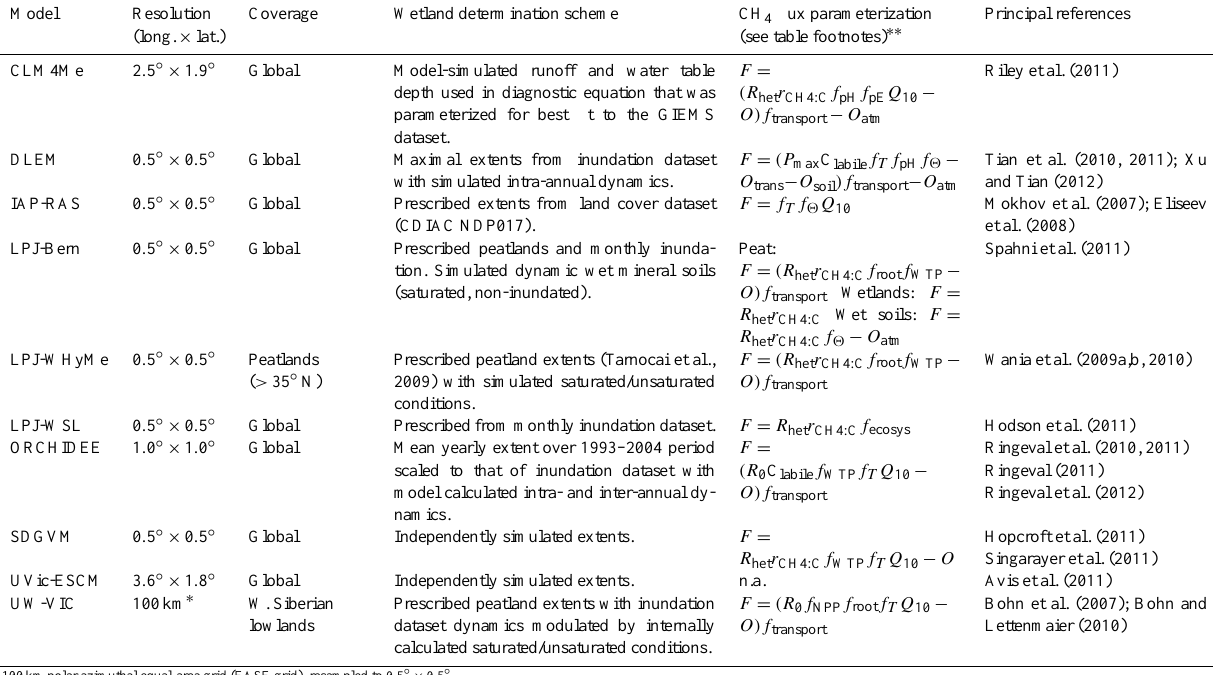
Table 1. List of WETCHIMP participating models. Not all models contributed results to all experiments. The conceptualized, general description of net methane flux, F , by each model is adapted from Table 5 in Wania et al. (2012). This formulation is for illustrative purposes; thus the main variables and parameters used in CH 4 production are detailed, but oxidation, O , and atmospheric oxidation, O atm , are not. For all results presented in this paper, all O atm values were set to 0, allowing comparison of modelled gross fluxes. All variables listed are described in the table footnotes. Note that identical parameters/variables for different models do not imply identical values used in the models. A full listing of contributed experiments and model set-ups for the experiments, as well as greater detail on the models’ methane flux parameterizations, is provided in Wania et al. (2012). Principal references (long. × lat.) (see table footnotes) ∗∗ Model-simulated runoff and water table depth used in diagnostic equation that was parameterized for best fit to the GIEMS